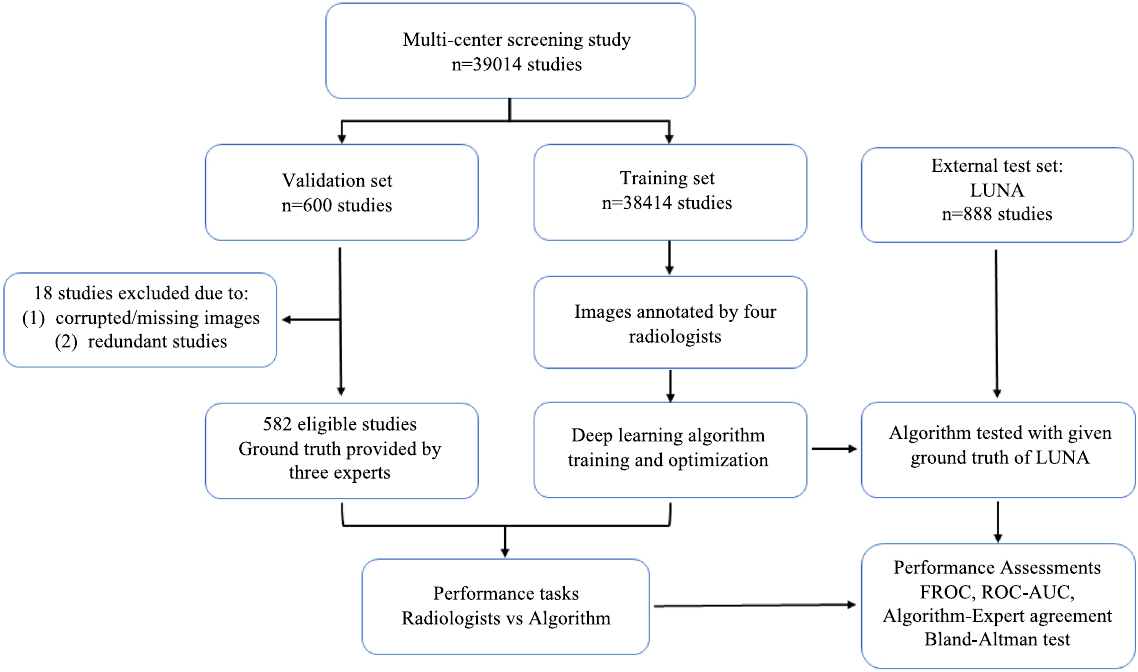
Figure 1. Data flowchart of the study design illustrating development process of a deep neural network-based learning algorithm, which was doubly tested with two datasets: a multi-centre validation set and the LUNA